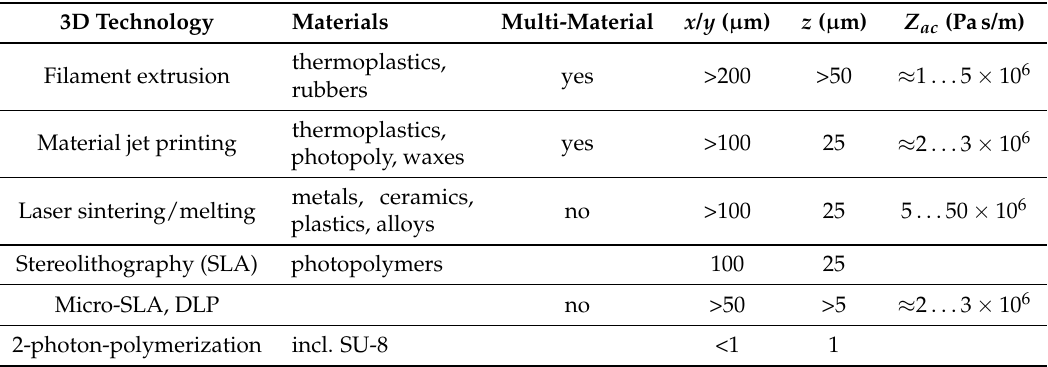
Table 1. Selected additive manufacturing technologies with typical minimum lateral ( x / y ) feature sizes and vertical slicing ( z ) after complete processing, as well as typical characteristic acoustic impedance ( Z ac ) for their standard range of